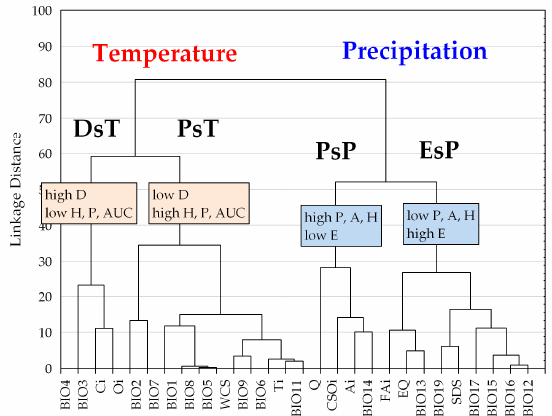
Figure 5. Tree diagram constructed on six response function measures on 27 bioclimatic variables (Euclidean distance, complete linkage). DsT = Decay-specific Temperature group; PsT = Prevalence-specific Temperature group; PsP = Prevalence-specific Precipitation group; EsP = Exclusion-specific Precipitation group. Name of the groups corresponds to the most important adaptation measure performing in their differentiation (Mann-Whitney U-test; p < 0.05; results are not presented). For detailed explanation of response function measures (P; D; E; A; H; AUC) and the description of bioclimatic variables (from BIO4 to BIO12) see Table 2 and Section 2.4.